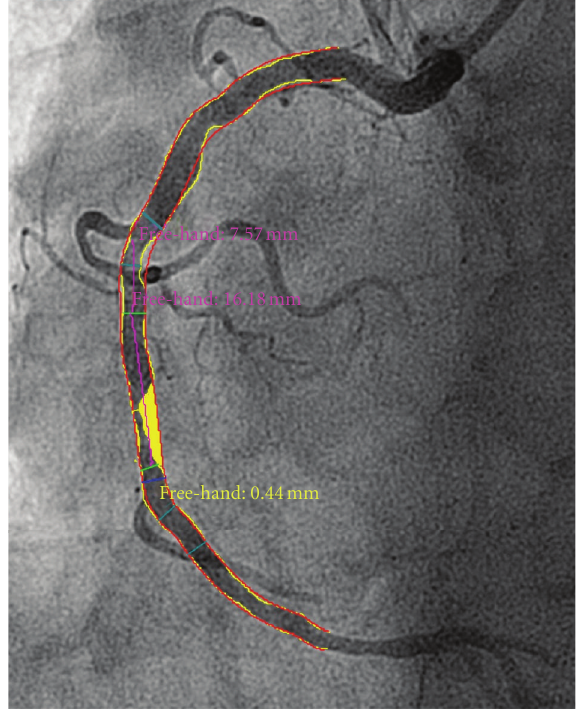
Figure 5: A typical example of a QCA analysis (Medis QAngio, Medis, The Netherlands) of a right coronary artery. Lumen area (in mm 2 ) is defined as the area around the lesion area (yellow area) in a clearly defined vessel segment (in-stent; in-segment) (green